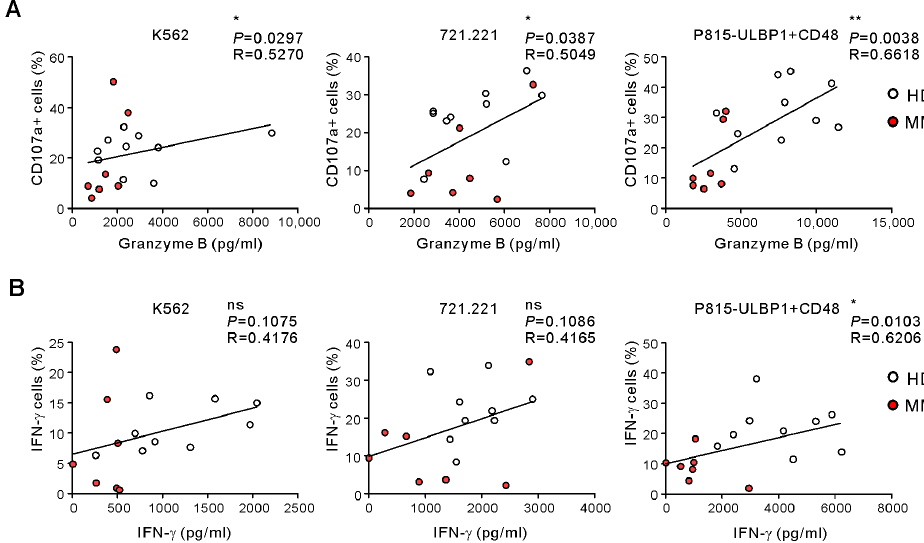
Figure 3. Correlation between PBMC-based NKA assay and WB-based NKA assay. ( A ) Correlation between granzyme B levels and the frequencies of CD107a+ NK cells. ( B ) Correlation between IFN- γ levels and the frequencies of IFN- γ + NK cells. * p < 0.05 and ** p < 0.01; Spearman’s correlation test ( A , B ).